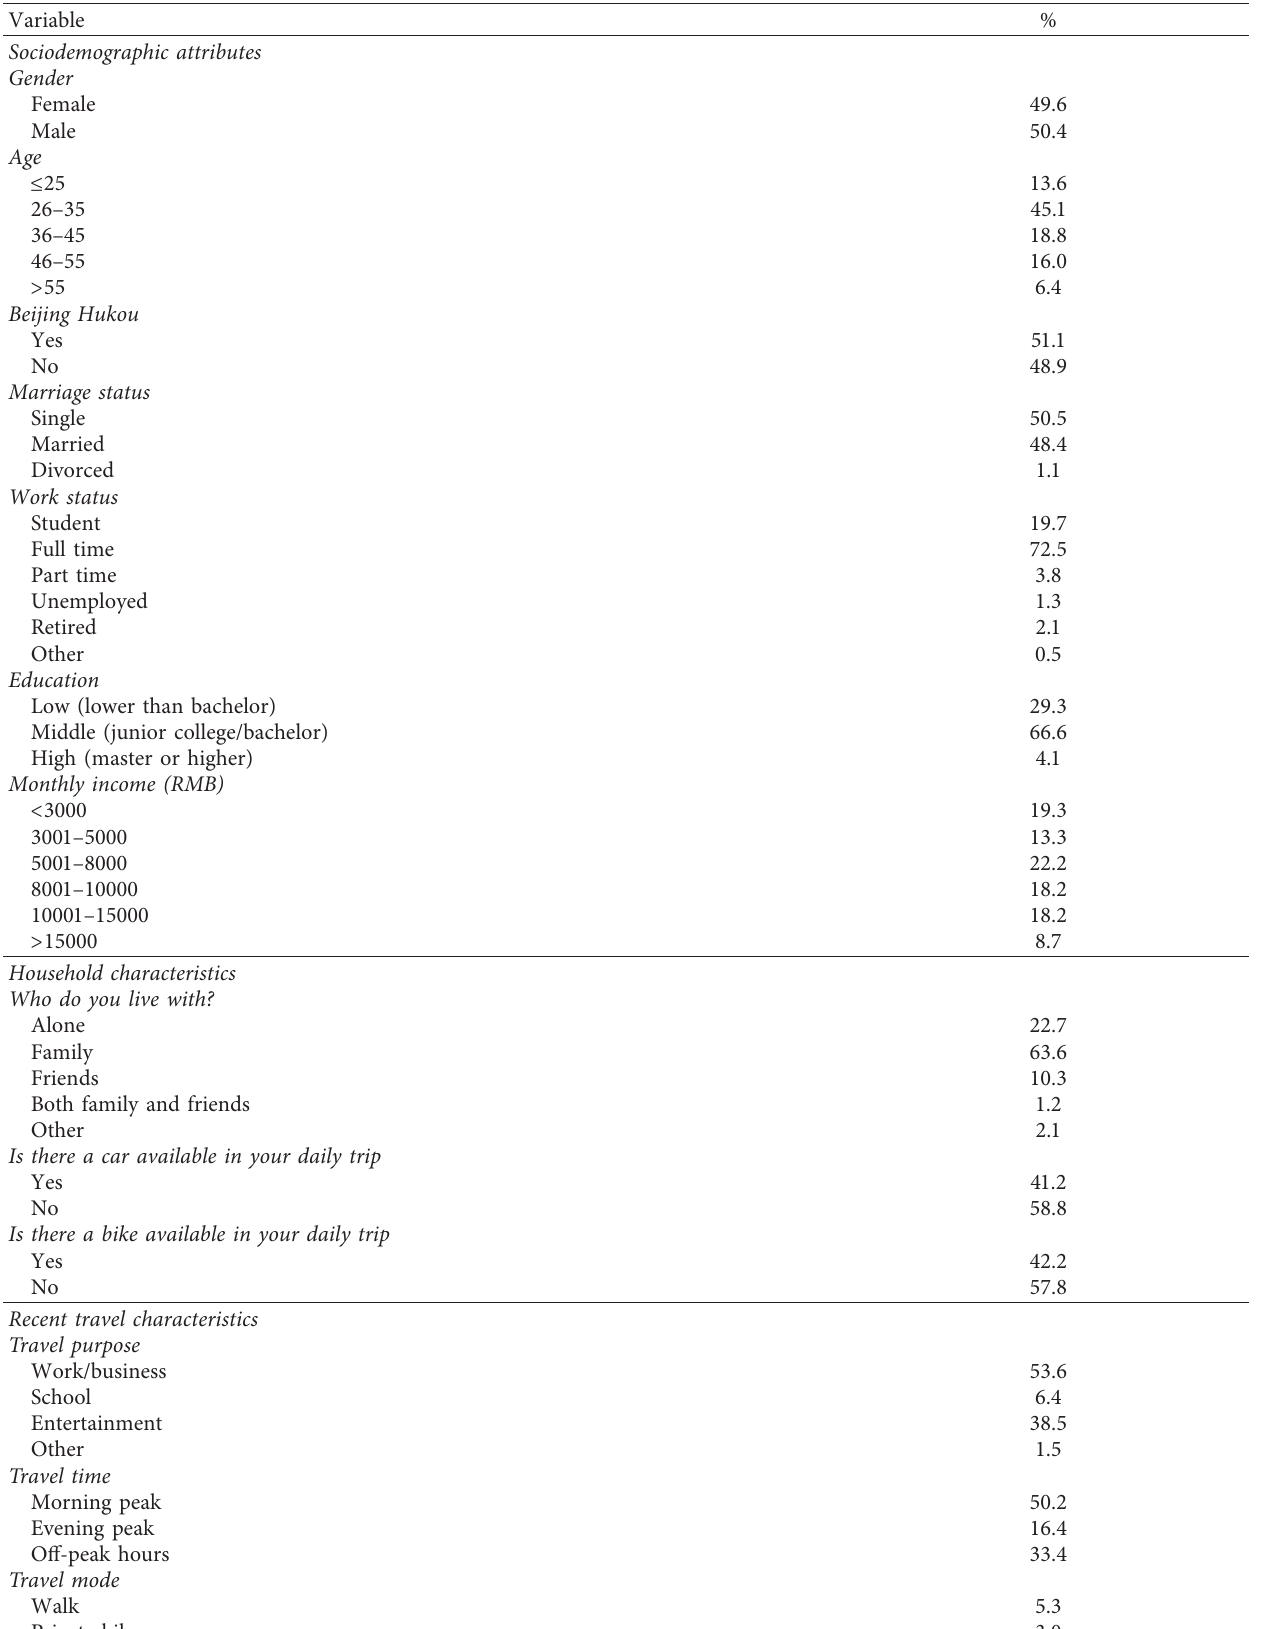
Table 3: Sample descriptions (N �